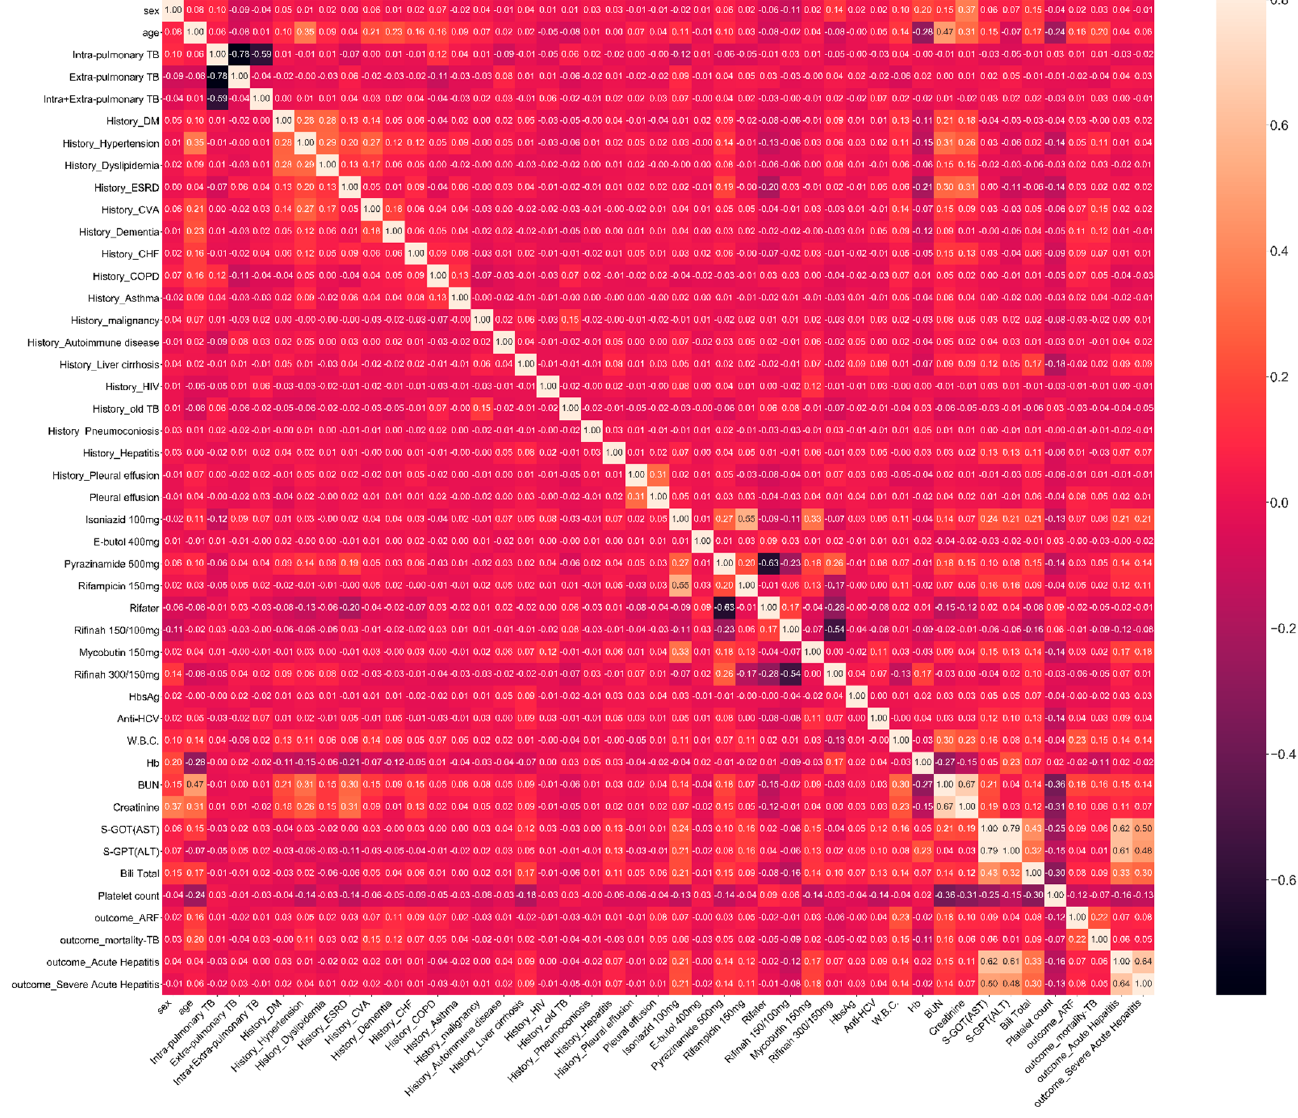
Table 2. Model results: mortality.